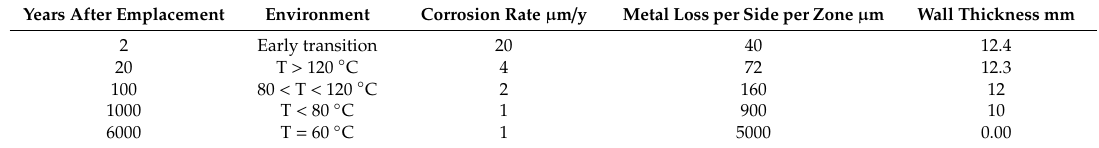
Table 5. Corrosion of L80 steel casing: penetration per zone per side and remaining wall thickness. Years After